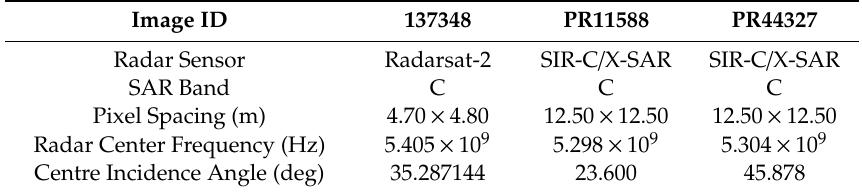
Table 2. Details of Synthetic Aperture Radar (SAR) image